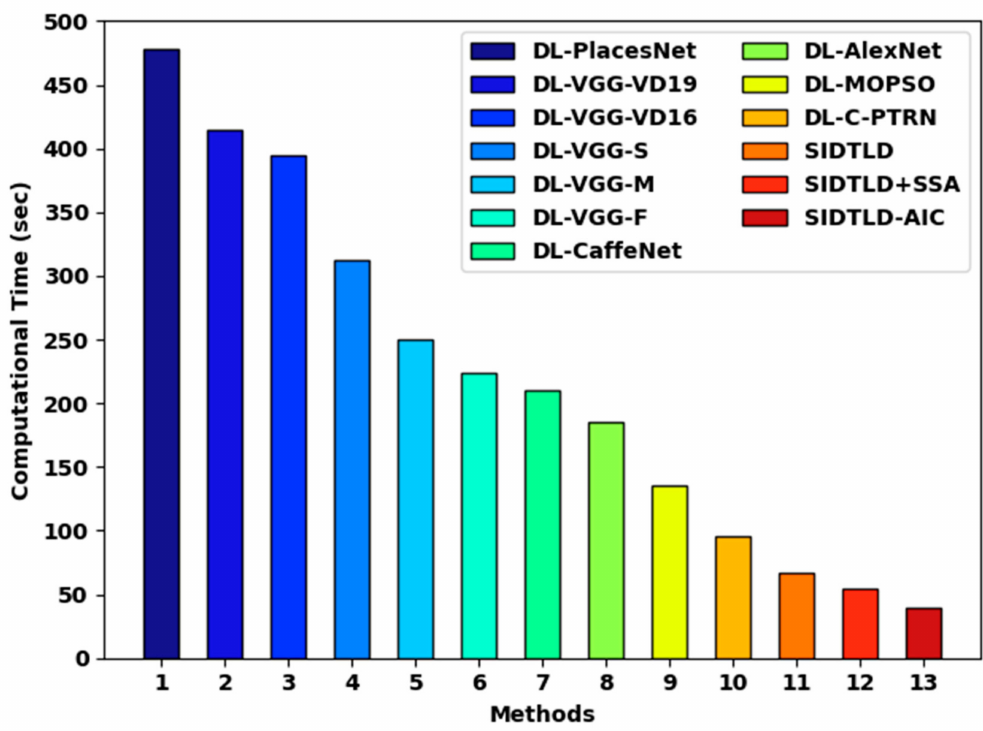
Figure 12. CT analysis of SIDTLD-AIC technique with existing